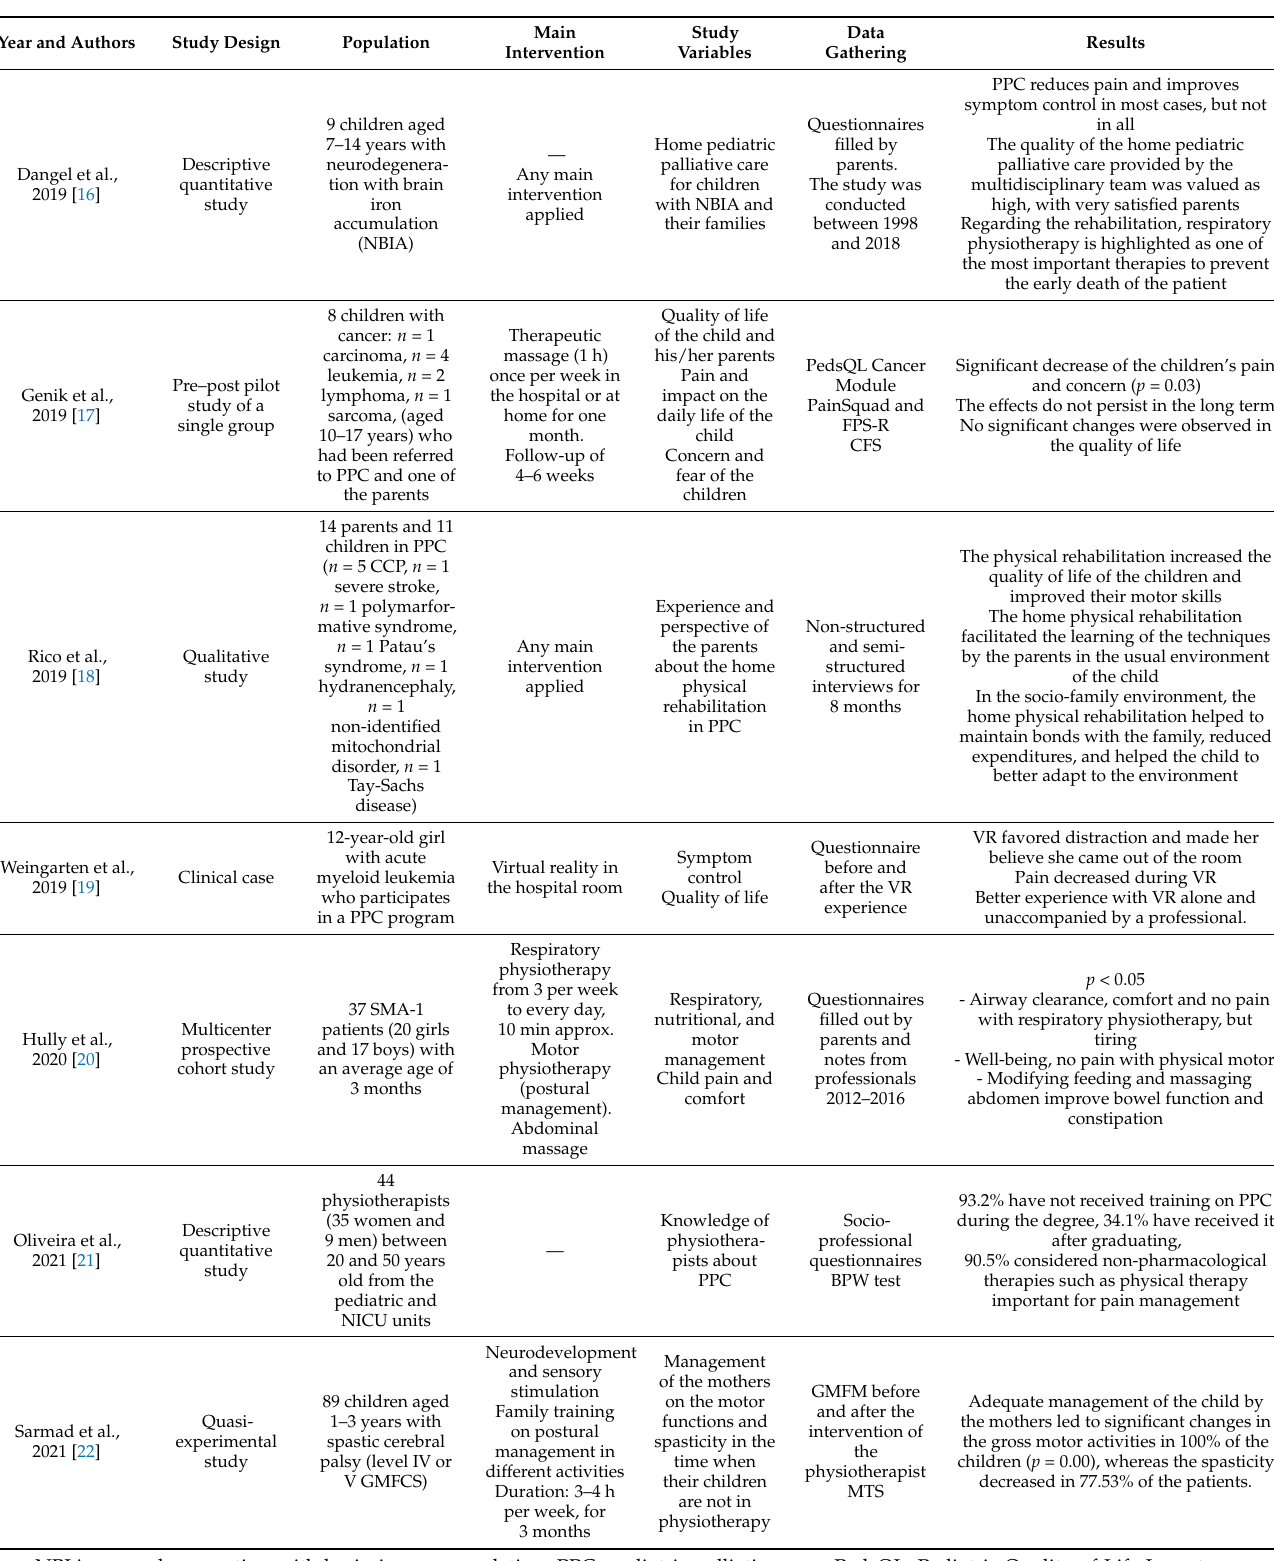
Table 4. Main characteristics of the selected